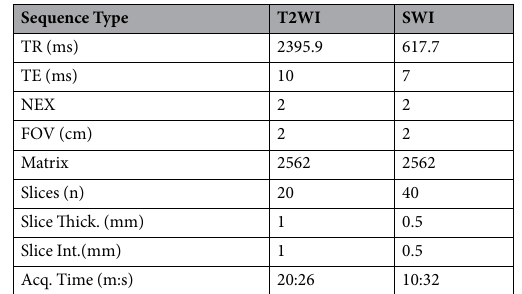
Table 1. MRI Sequence